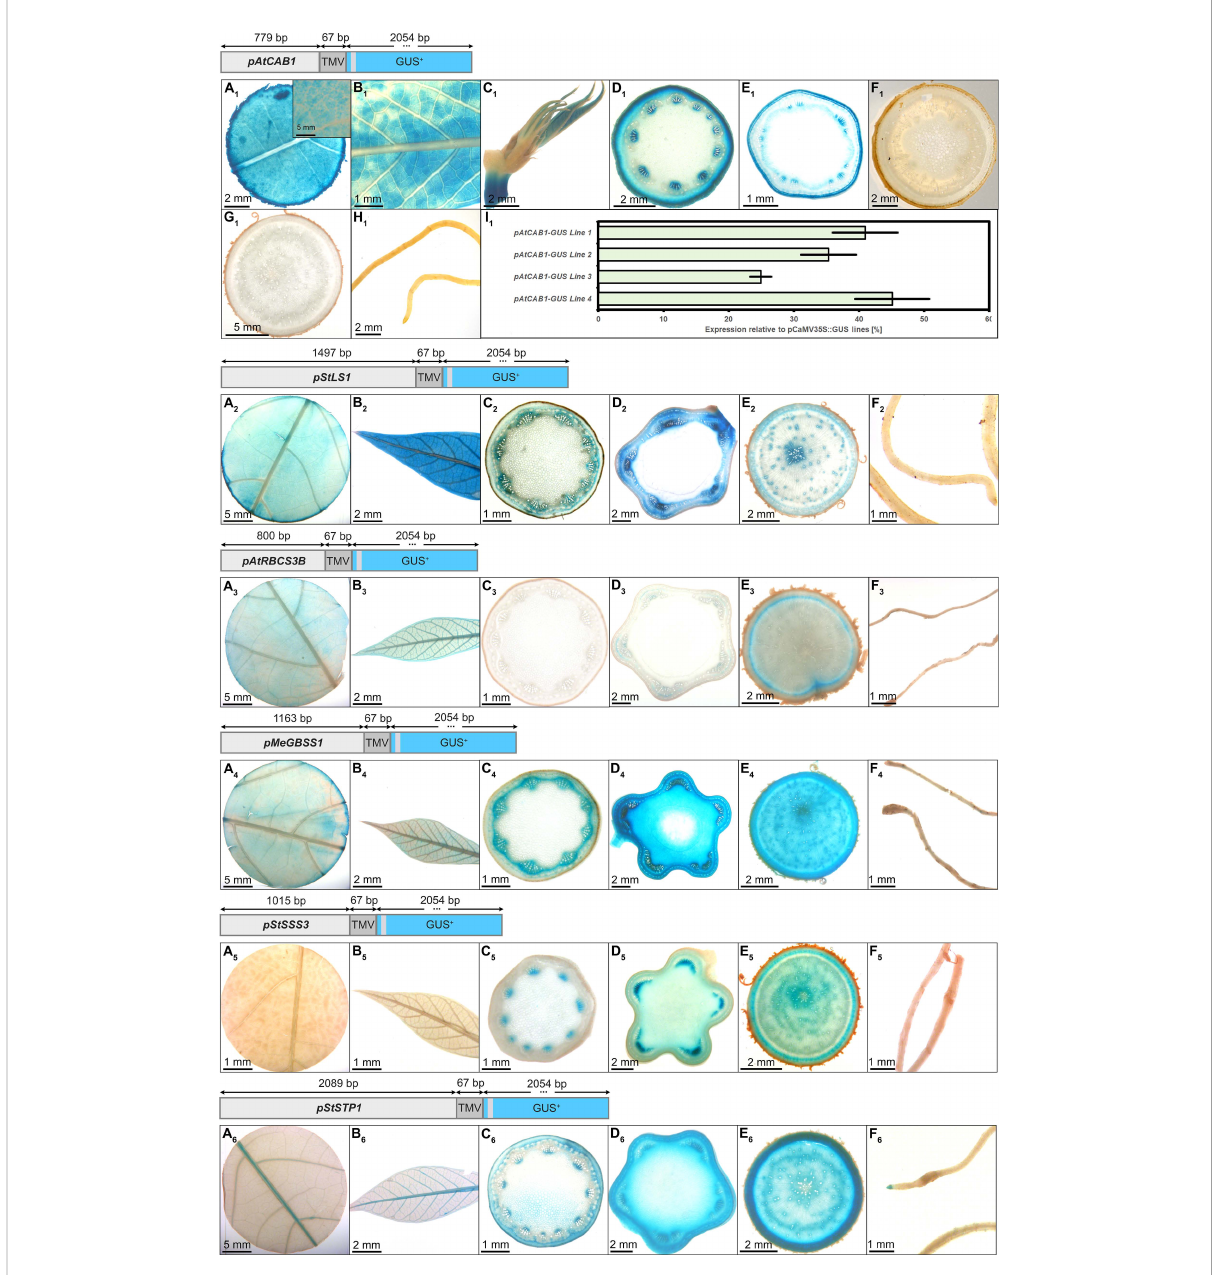
FIGURE 2 Representative GUS staining pattern of at least three events from pAtCAB1::GUS , pStLS1::GUS , pAtRBCS3B::GUS , pMeGBSS1 , pStSSS3 , and pStSTP1 promoter-reporter plants. pAtCAB1::GUS = A 1 ) Source leaf (Inlay = Close-up), B 1 ) Sink leaf, C 1 ) Emerging leaves, D 1 ) Petiole cross- section, E 1 ) Upper stem cross-section, F 1 ) Lower stem cross-section, G 1 ) Storage root cross-section, H 1 ) Fibrous roots, I 1 ) GUS expression levels of four pAtCAB1::GUS lines relative to three pCaMV35S::GUS lines in %. pStLS1::GUS = A 2 ) Source leaf, B 2 ) Sink leaf, C 2 ) Petiole cross-section, D 2 ) Upper stem cross-section, E 2 ) Storage root cross-section, H 2 ) Fibrous roots. pAtRBCS3B::GUS = A 3 ) Source leaf, B 3 ) Sink leaf, C 3 ) Petiole cross-section, D 3 ) Upper stem cross-section, E 3 ) Storage root cross-section, H 3 ) Fibrous roots. p MeGBSS1::GUS = A 4 ) Source leaf, B 4 ) Sink leaf, C 4 ) Petiole cross-section, D 4 ) Upper stem cross-section, E 4 ) Storage root cross-section, H 4 ) Fibrous roots. p StSSS3::GUS = A 5 ) Source leaf, B 5 ) Sink leaf, C 5 ) Petiole cross-section, D 5 ) Upper stem cross-section, E 5 ) Storage root cross-section, H 5 ) Fibrous roots. p StSTP1::GUS = A 6 )